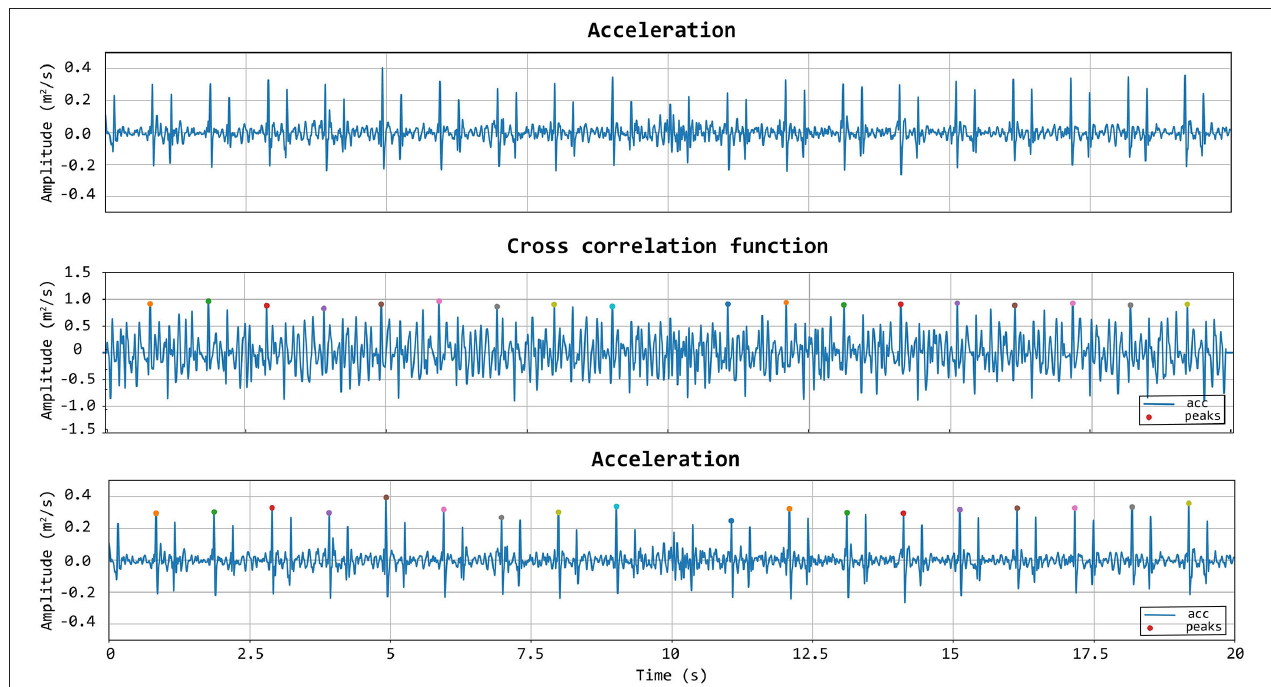
FIGURE 7 | First row: acceleration signal. Second row: normalized cross-correlation function and its maximum values of the acceleration signal with the femoral template of 500 ms. Last row: acceleration signal with the detected peaks using the template matching